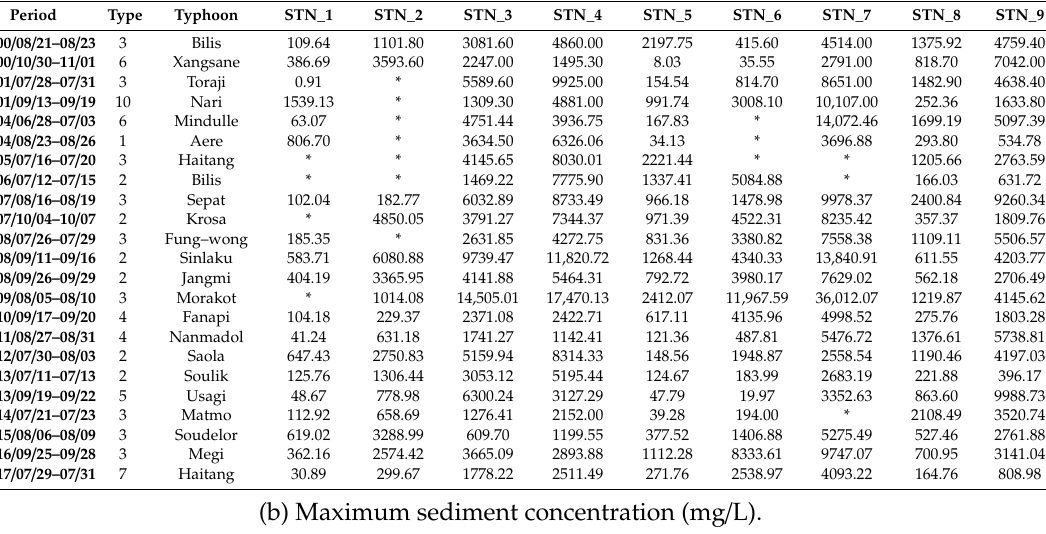
Table 4. Historical information about typhoons during 2000–2017. (a) Accumulated daily discharge (m 3 /